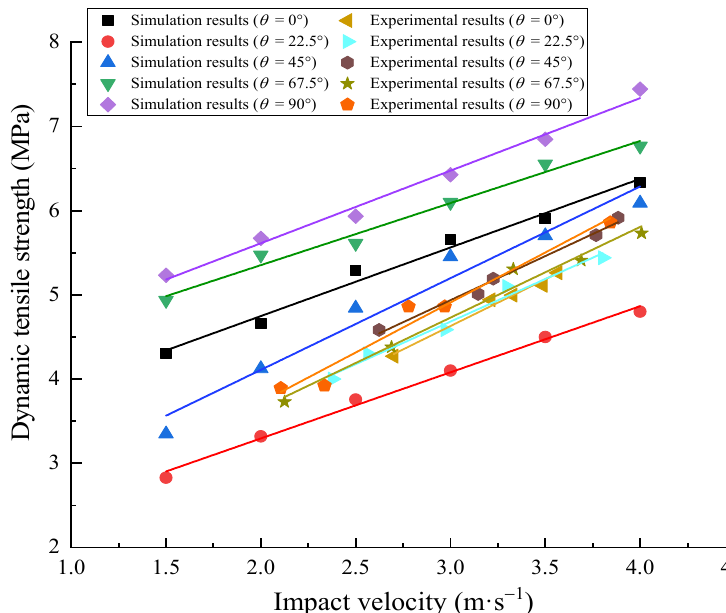
Figure 28. Comparative plots between the impact velocity and dynamic tensile strength curves ob ‐ tained from experiments and numerical simulations.